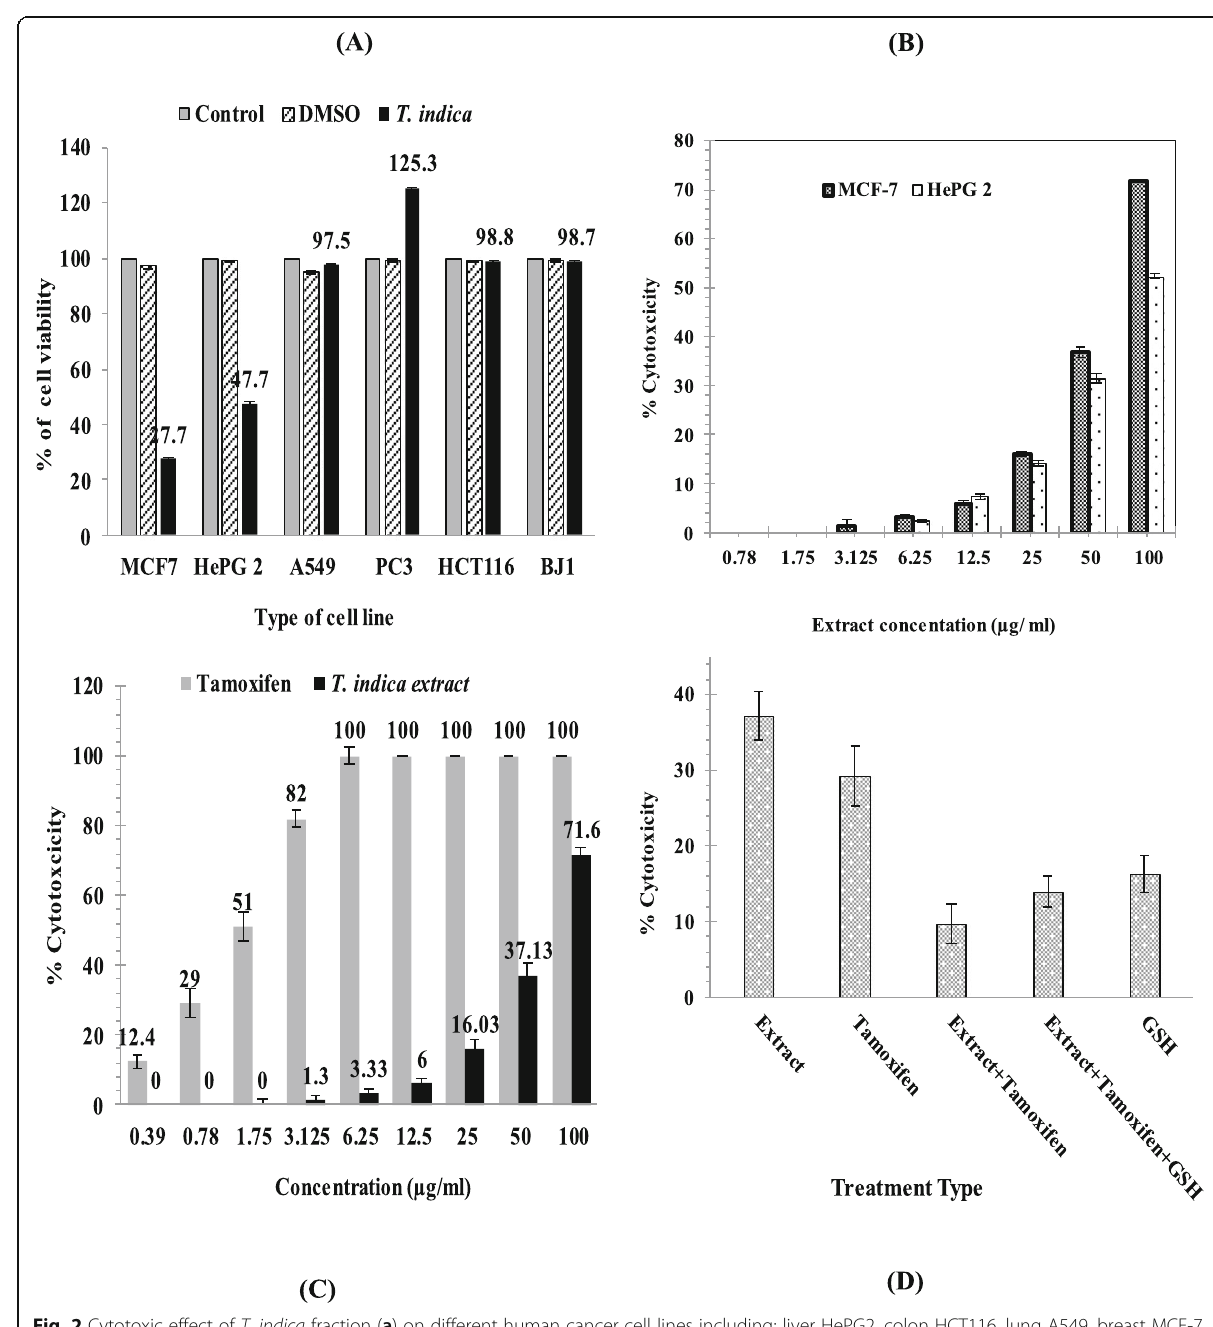
Fig. 2 Cytotoxic effect of T. indica fraction ( a ) on different human cancer cell lines including: liver HePG2, colon HCT116, lung A549, breast MCF-7, prostate PC3, and the normal skin fibroblast, BJ1; ( b ) using different concentrations on human breast MCF-7 and hepatocellular carcinoma, HePG2; ( c ) using different concentrations of extract and tamoxifen on MCF-7 cell count and viability ( d ) combination treatment of IC 25 concentration of T. indica fraction (47.3 μ g/ml); tamoxifen (0.8 μ g/ml), glutathione (GSH) on MCF-7 cytotoxicity. Error bars represent standard deviation from the mean ( ┬